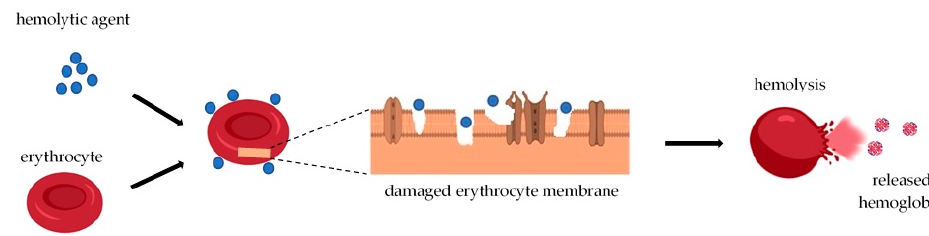
Figure 1. Basic mechanism of hemolysis.